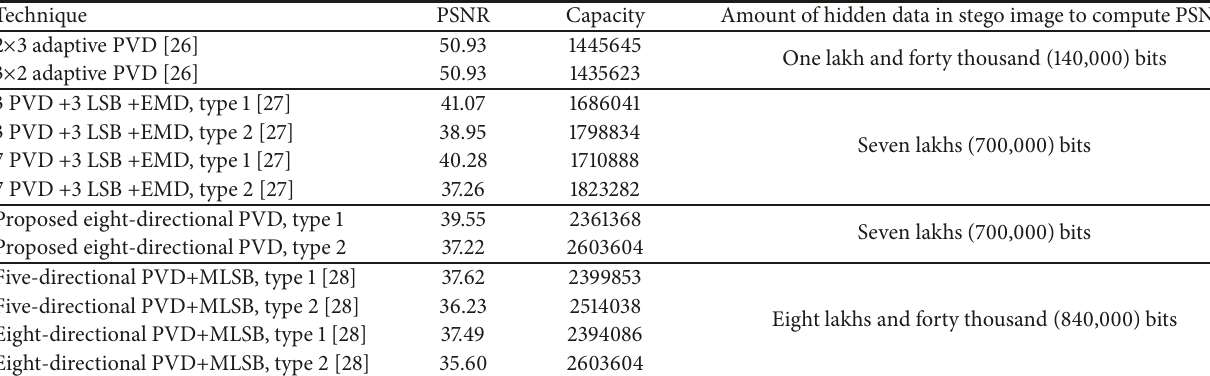
Table 6: Comparison of the proposed technique with techniques in